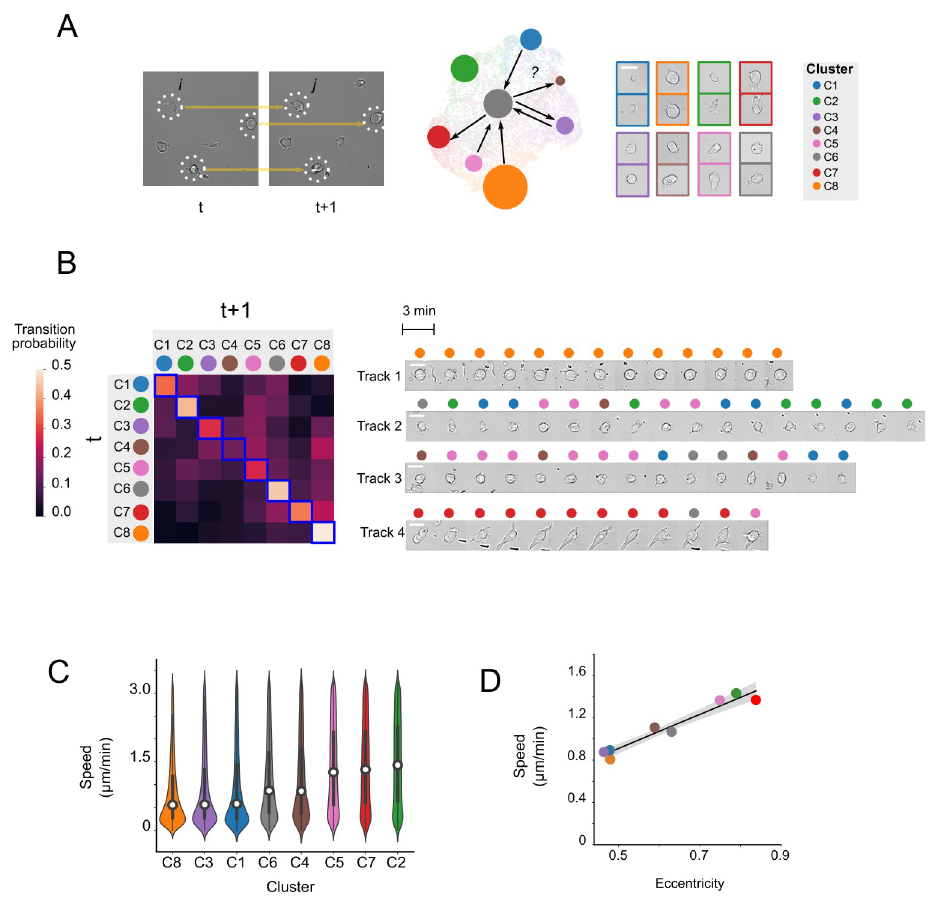
Fig 6. Calculation of morphological state transition probabilities by cell linkage analysis. (A) Cell pairs found in proximity across on successive time points were linked (left). Cell linkages, along with assigned morphological states of linked cells, were used to calculate transition probabilities between all states. (B) Heatmap shows transition probability matrix between all morphological clusters (left); image montage shows representative cell tracks identified from the culture (right). Scale bar represents 10 μ m. (C) Distribution of cellular velocity for linked cells for each morphological cluster. (D) Plot shows mean cell velocity against mean cell eccentricity for each morphological